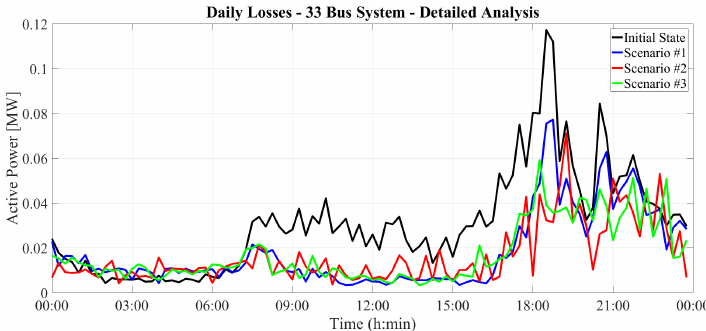
Figure 17. Detailed Analysis—Daily Losses profile for all Scenarios.